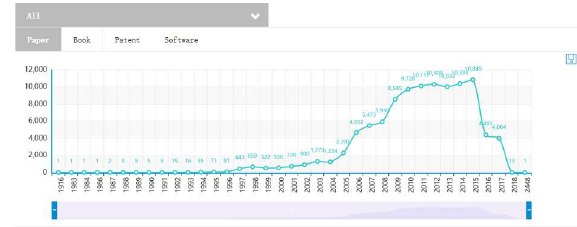
Figure 6. Teaching ability-paper Correlation analysis of teachers' teaching ability and the number of papers (Figure 6);